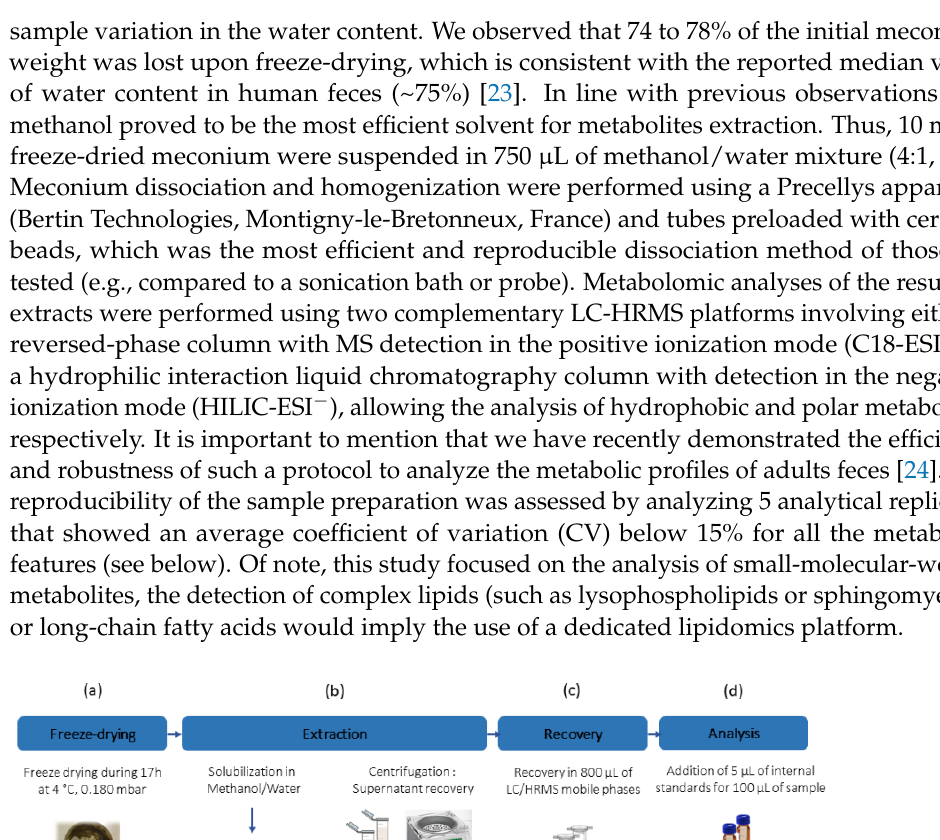
Figure 1. Optimized protocol for meconium preparation prior to LC-HRMS analysis. Four major steps were considered, and the corresponding optimized conditions are provided: ( a ) freeze-drying parameters, ( b ) metabolites extraction method, ( c ) recovery of the pellet containing the metabolites, and ( d ) LC-HRMS analytical conditions.